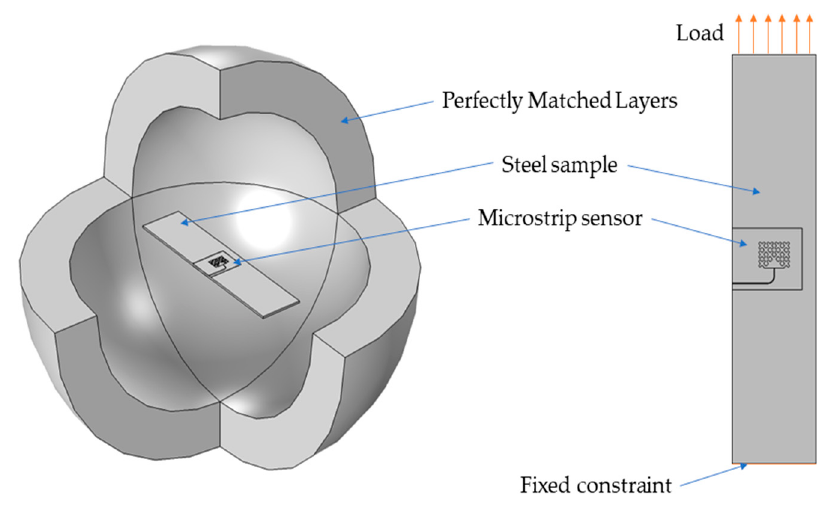
Figure 4. Finite Element Method (FEM) numerical model.